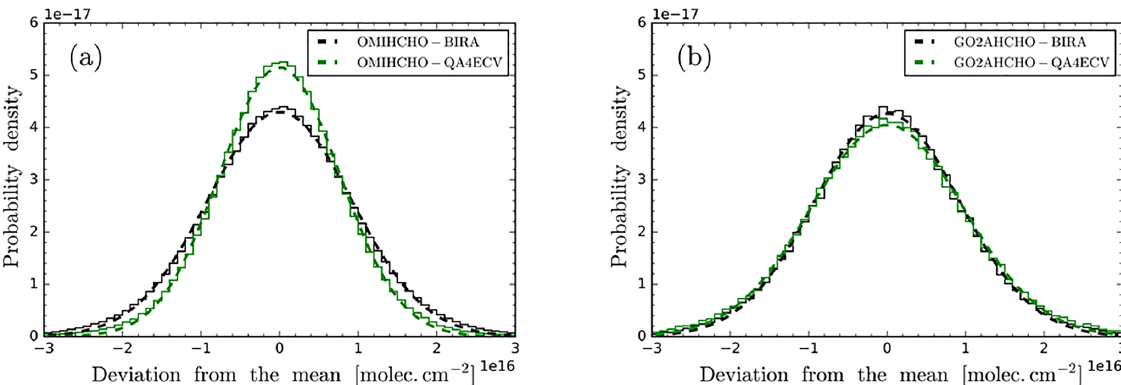
Figure 6. (a) Distribution of the deviation of the SCDs from the mean SCD within a box (for all boxes) in a histogram for OMIHCHO– QA4ECV (green) against the reference OMIHCHO–BIRA (black) for the Pacific orbit from day 1 of January, April, July, and October 2005–2015. The width, σ , of the Gaussian provides an estimate of the SCD uncertainty for each SCD retrieval algorithm ( σ bira = 9 . 10 ± 0 . 04 × 10 15 molec.cm − 2 , σ qa4ecv = 7 . 55 ± 0 . 04 × 10 15 molec.cm − 2 ) . Panel (b) is as (a) but for GO2AHCHO–BIRA and GO2AHCHO– QA4ECV the Pacific orbits from day 1 of January up to December and from day 15 of January, April, July, and October 2007–June 2014 and 2007–2015 respectively were used ( σ bira = 10 . 11 ± 0 . 06 × 10 15 molec.cm − 2 , σ qa4ecv = 11 . 17 ± 0 . 07 × 10 15 molec.cm − 2 ) .